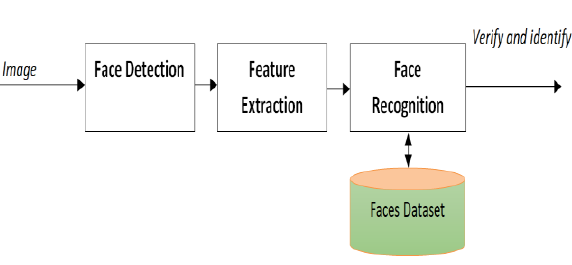
Figure 1 . The structure of the face recognition system